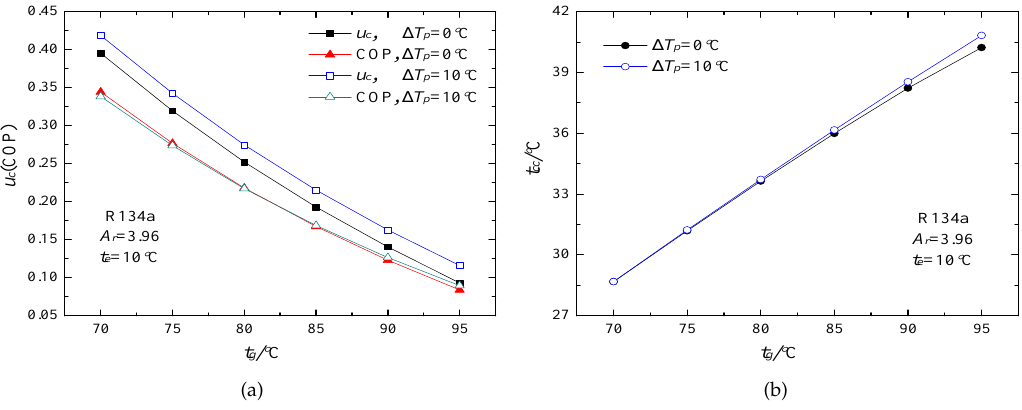
Figure 17. Critical entrainment ratio, COP and critical condensing temperature versus generating temperature using R134a as a working